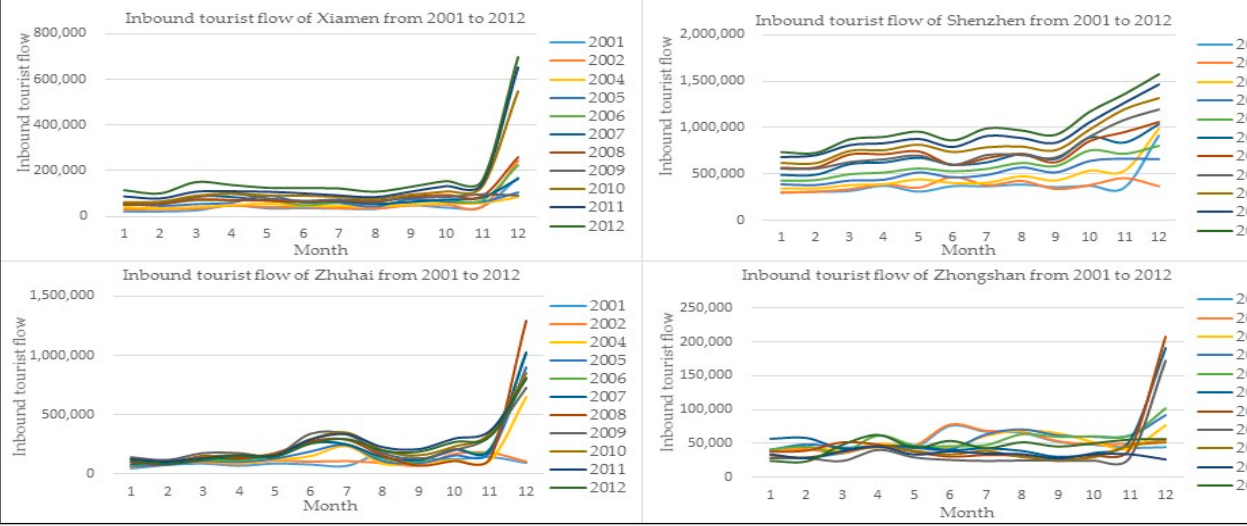
Figure 2. One-peak.